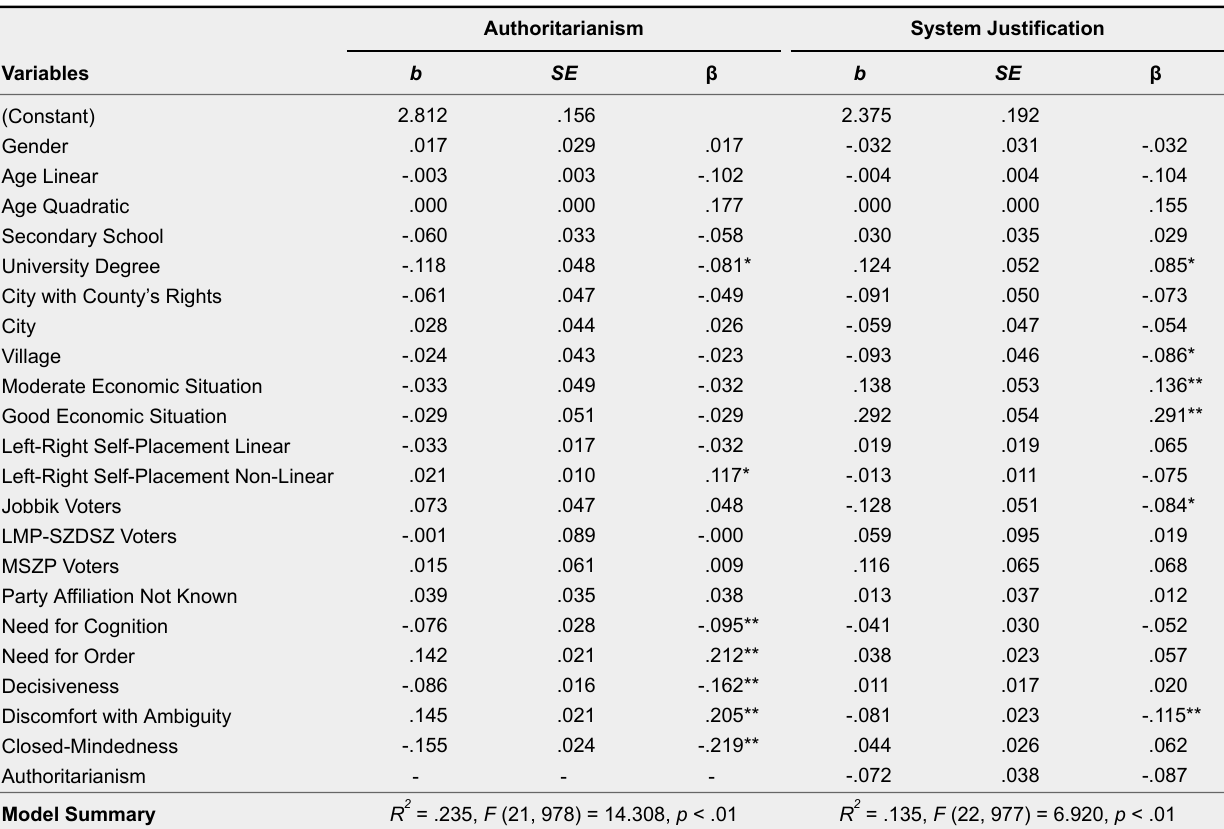
Multiple Regression Analyses After the Third Set of Predictors (Cognitive Style for Authoritarianism and Cognitive Style and Authoritarianism for System Justification) Were Added to the Model. Dependent Variables: Authoritarianism and System Justification (N =